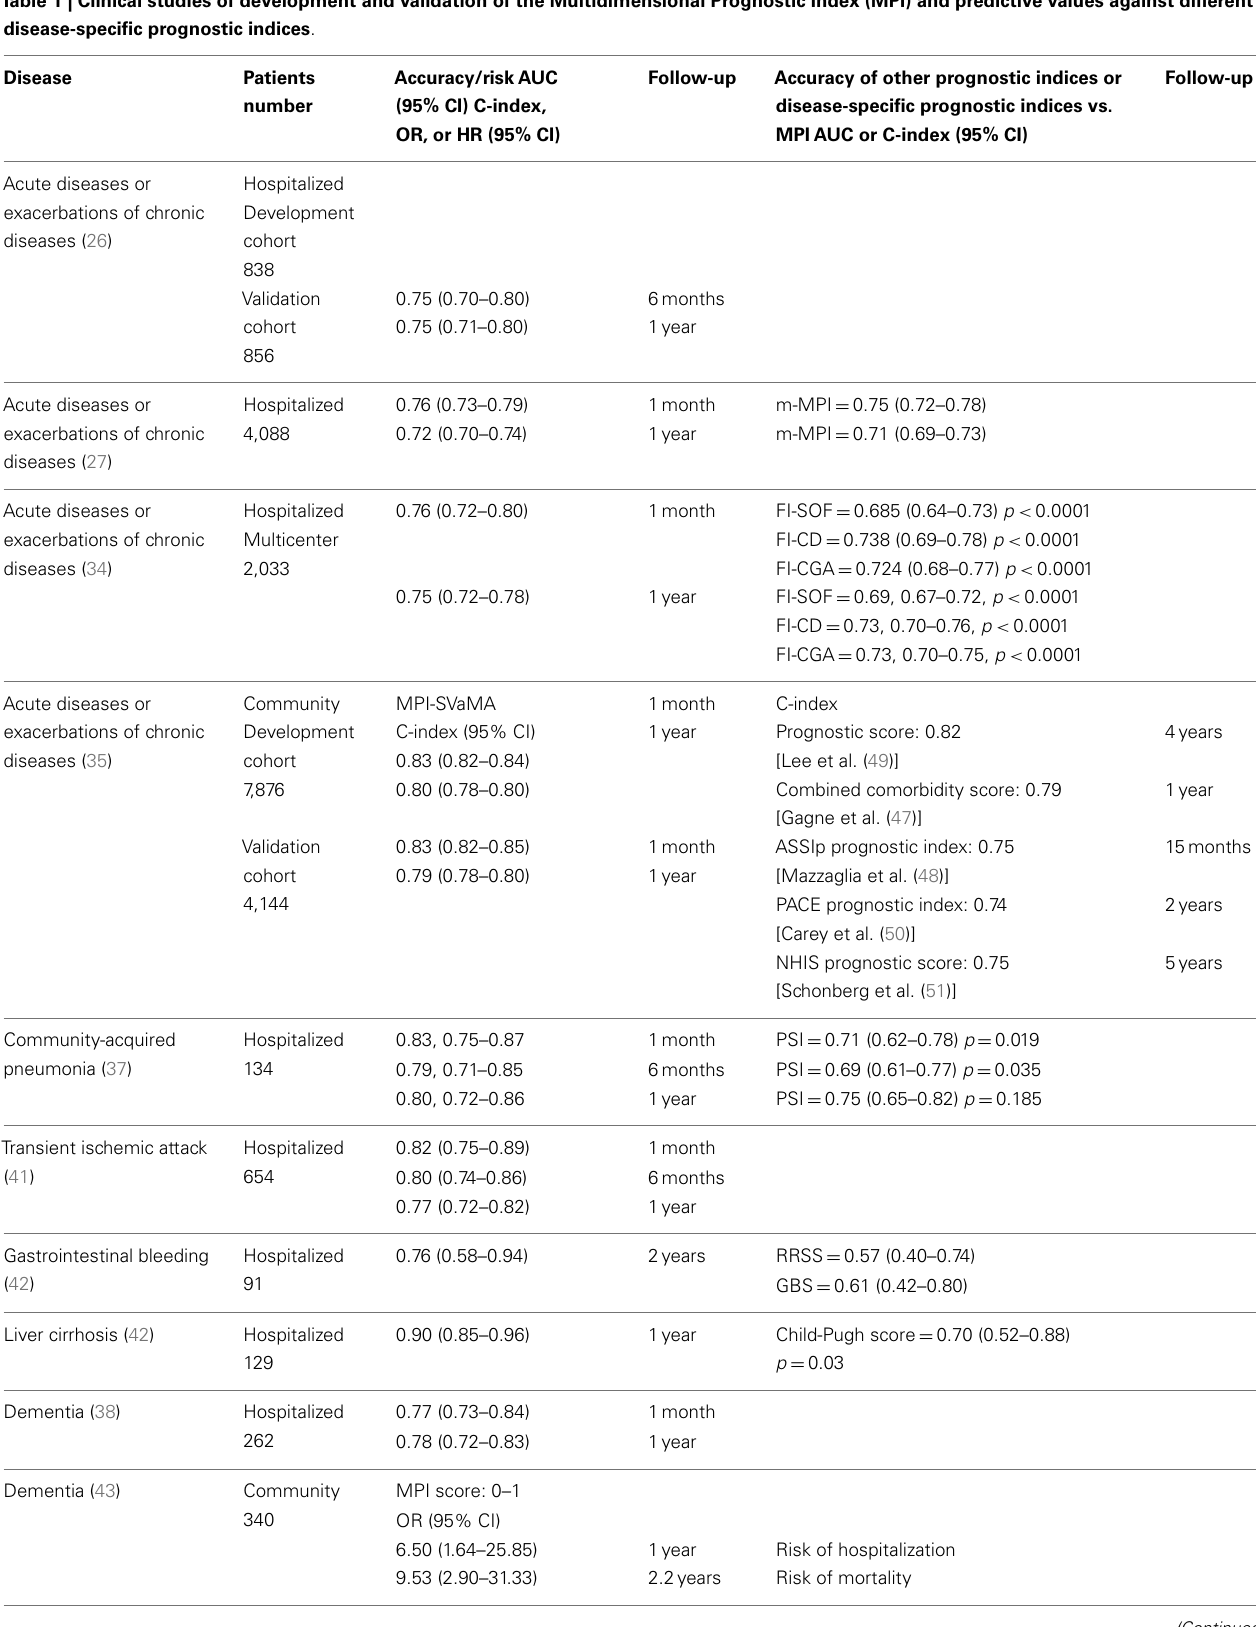
Table 1 | Clinical studies of development and validation of the Multidimensional Prognostic Index (MPI) and predictive values against different disease-specific prognostic indices .